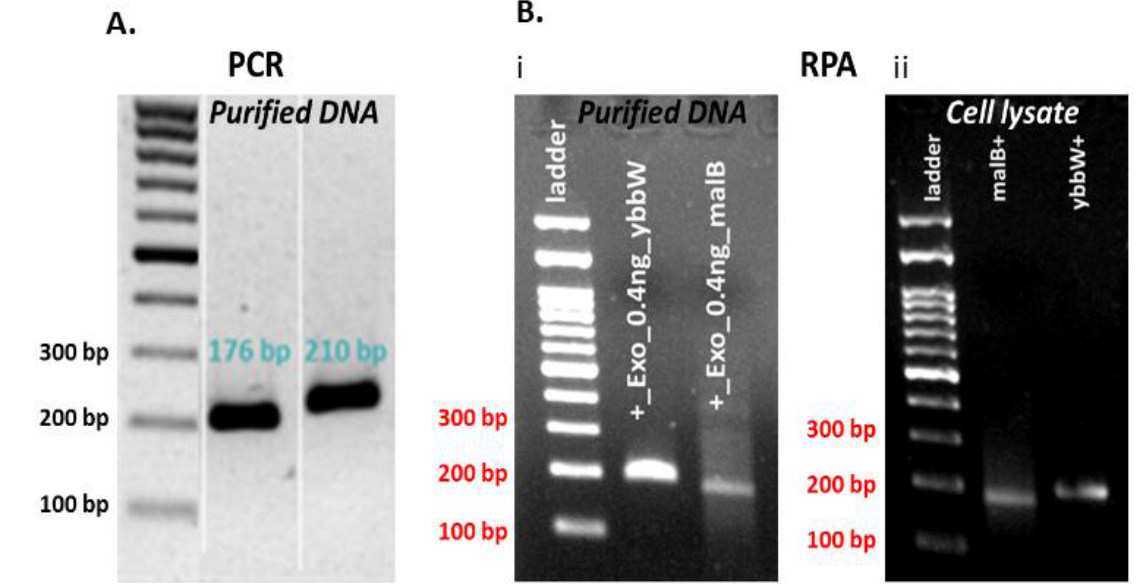
Figure 2. ( A ) Agarose gel electrophoresis (2%) of PCR products amplified by specific primer pairs for ybbW and malb genes with purified gDNA E. coli TOP10 (1 ng—2 × 10 5 copies DNA) template. ( B ) Agarose gel electrophoresis (2%) of RPA products amplified by target genes primer pairs with purified gDNA E. coli TOP10 (1 ng) and cell lysate (1 µ L—2 × 10 7 copies DNA) (thermal lysis) template .